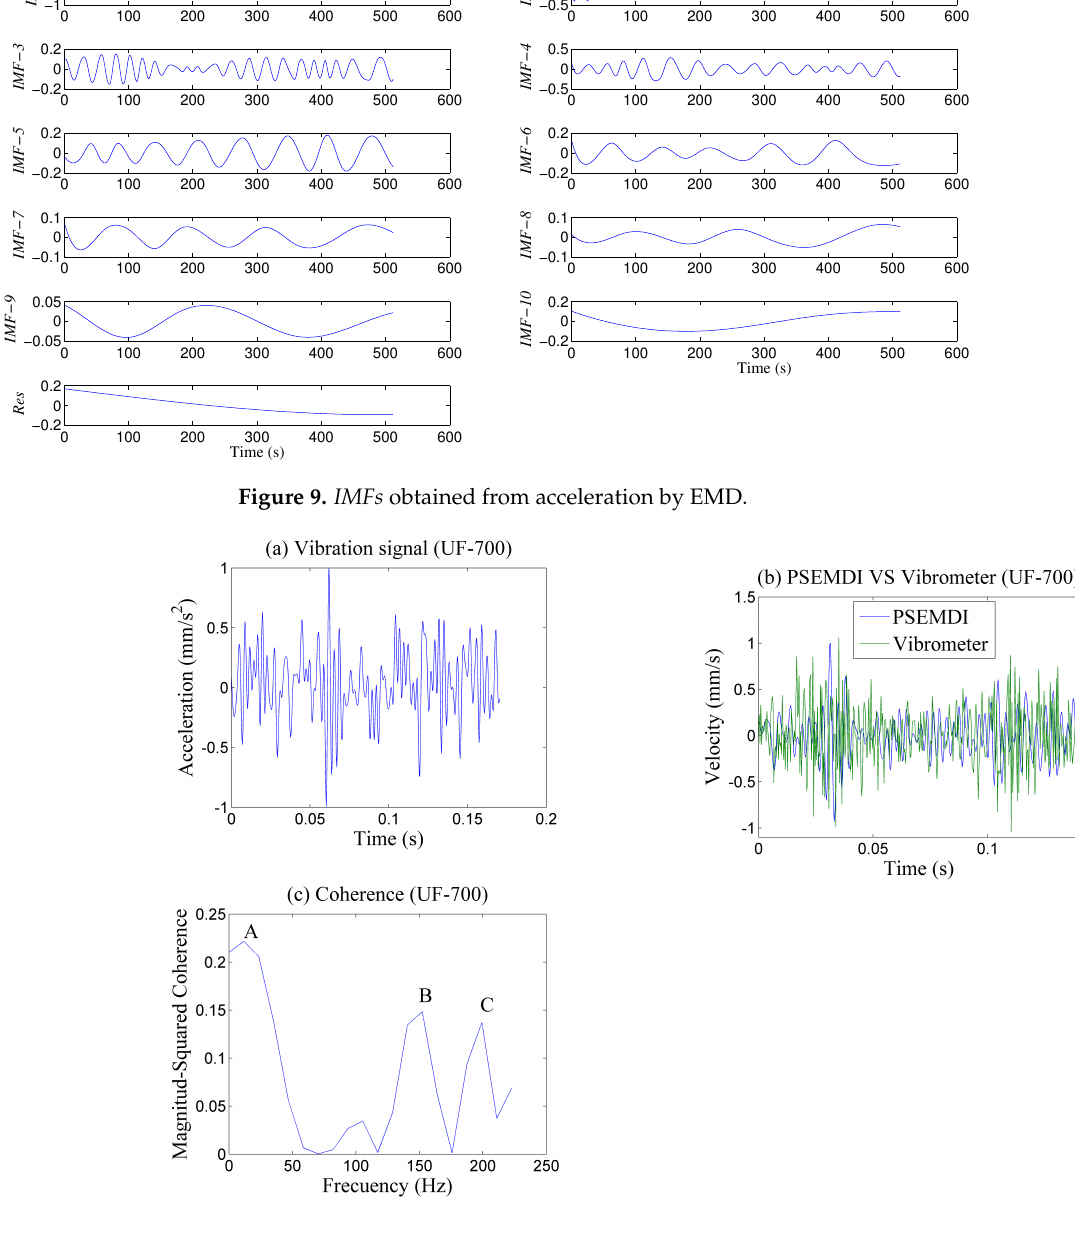
Figure 10. Comparison of PSEMDI velocity with laser vibrometer for the unbalanced disk and friction at 700 rpm: ( a ) Acceleration signal; ( b ) comparison of PSEMDI velocity and vibrometer; ( c ) coherence